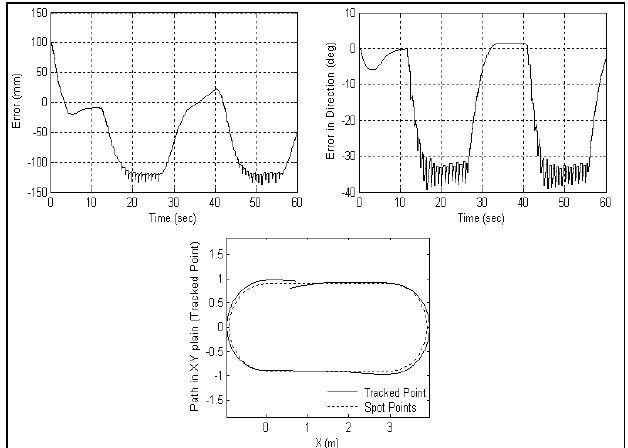
Fig. 16. Robot path with adaptive controller.